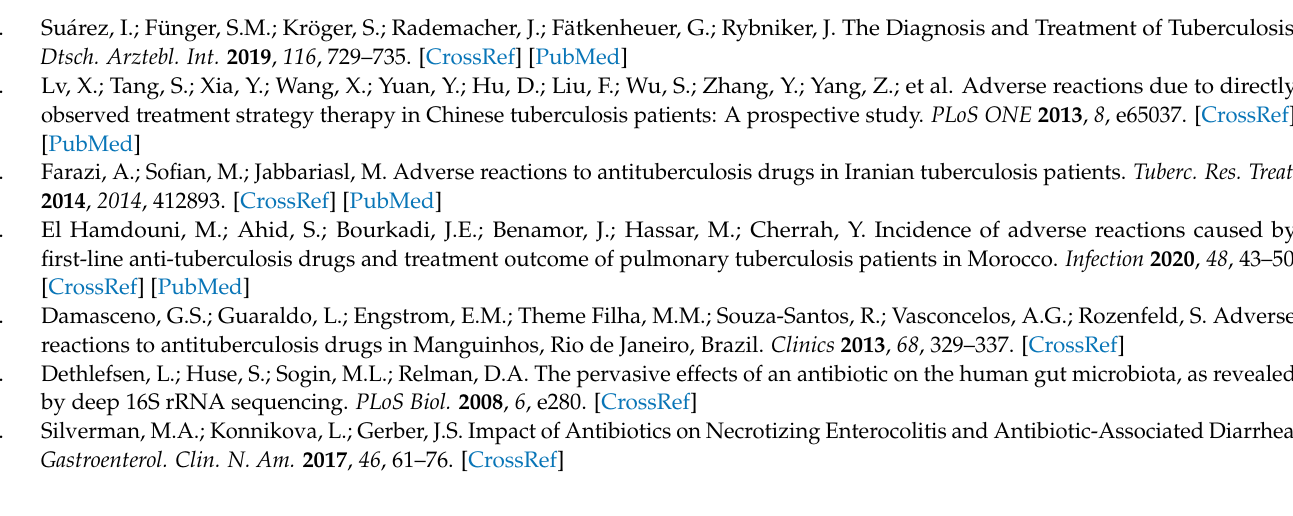
Figure S1: Comparison of short-chain fatty acid content between week 2 and week